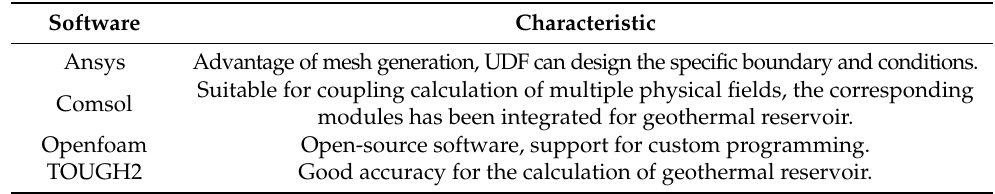
Table 3. Commercial software for solving geothermal reservoir. Software